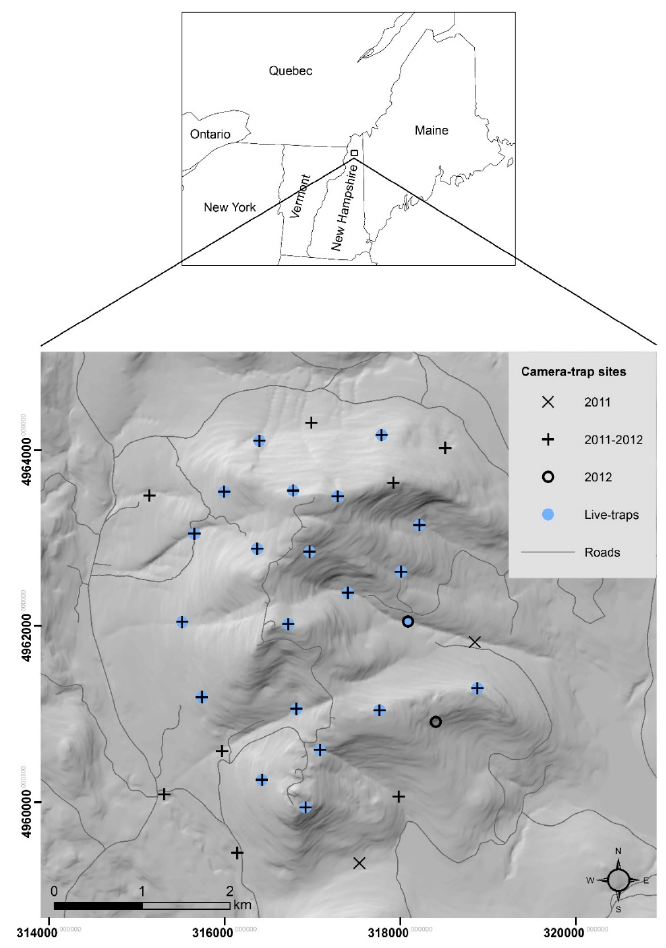
Figure 1. Study area used to develop the camera-trap method to identify radio-collared and un-collared American martens ( Martes americana ) and estimate density in northern New Hampshire, USA.